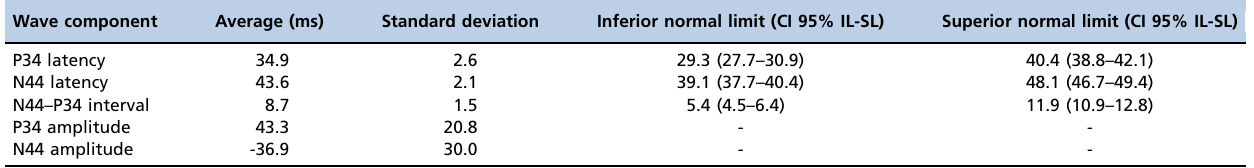
Note: The limits of normality for amplitudes were not calculated since the asymmetry index was used for this measurement. Table 2 - Average amplitudes, standard deviation, and asymmetry index between the ears for the forearm VEMP. Wave component P34 amplitude (R)